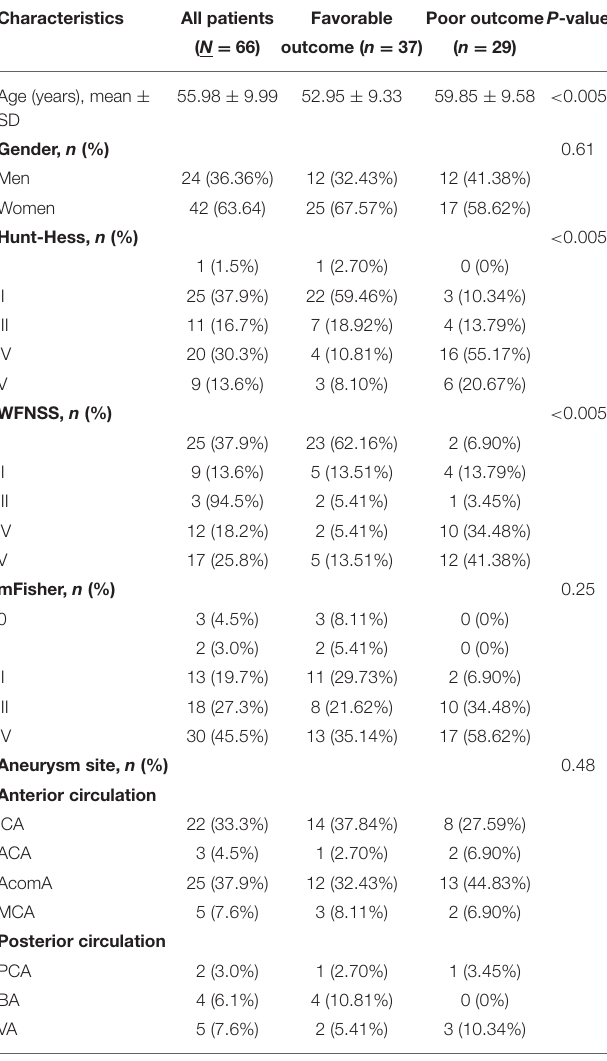
TABLE 2 | Comparison of PBV on the bleeding side hemisphere and the non-bleeding side hemisphere.